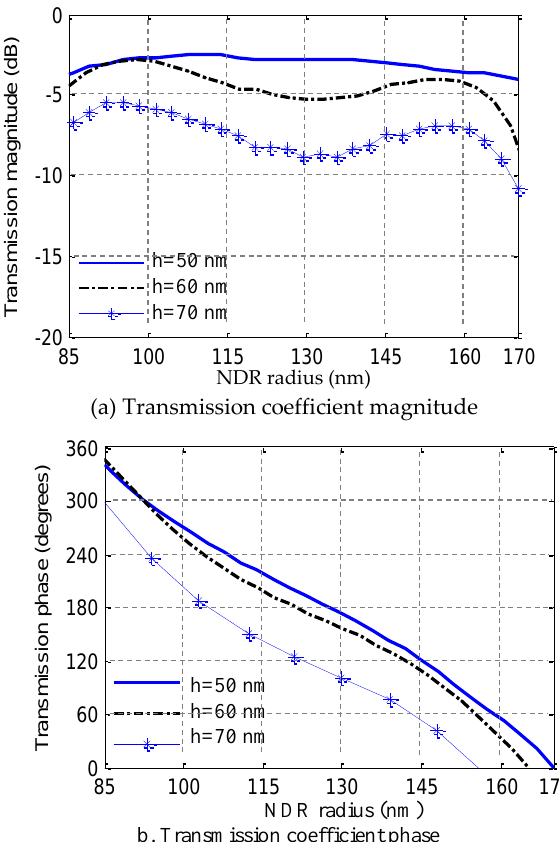
Figure 13 The variations of the transmission coefficient magnitude and phase versus the NDR radius with silver supporting plane thickness L =350 nm, h d =50 nm.